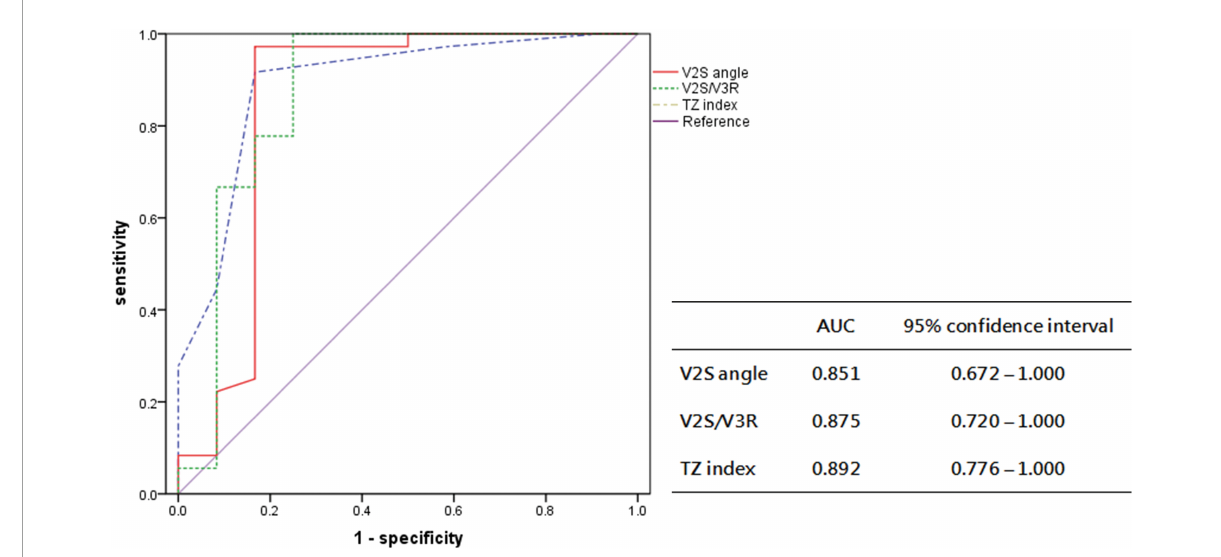
FIGURE6 Receiver operating characteristic curve analysis for the anatomic prediction of OTVA origin with V2S angle and previous indexes in the prospective cohort. The AUC of V2S angle was 0.851, similar to that of V2S/V3R (0.875) and the TZ index (0.892).